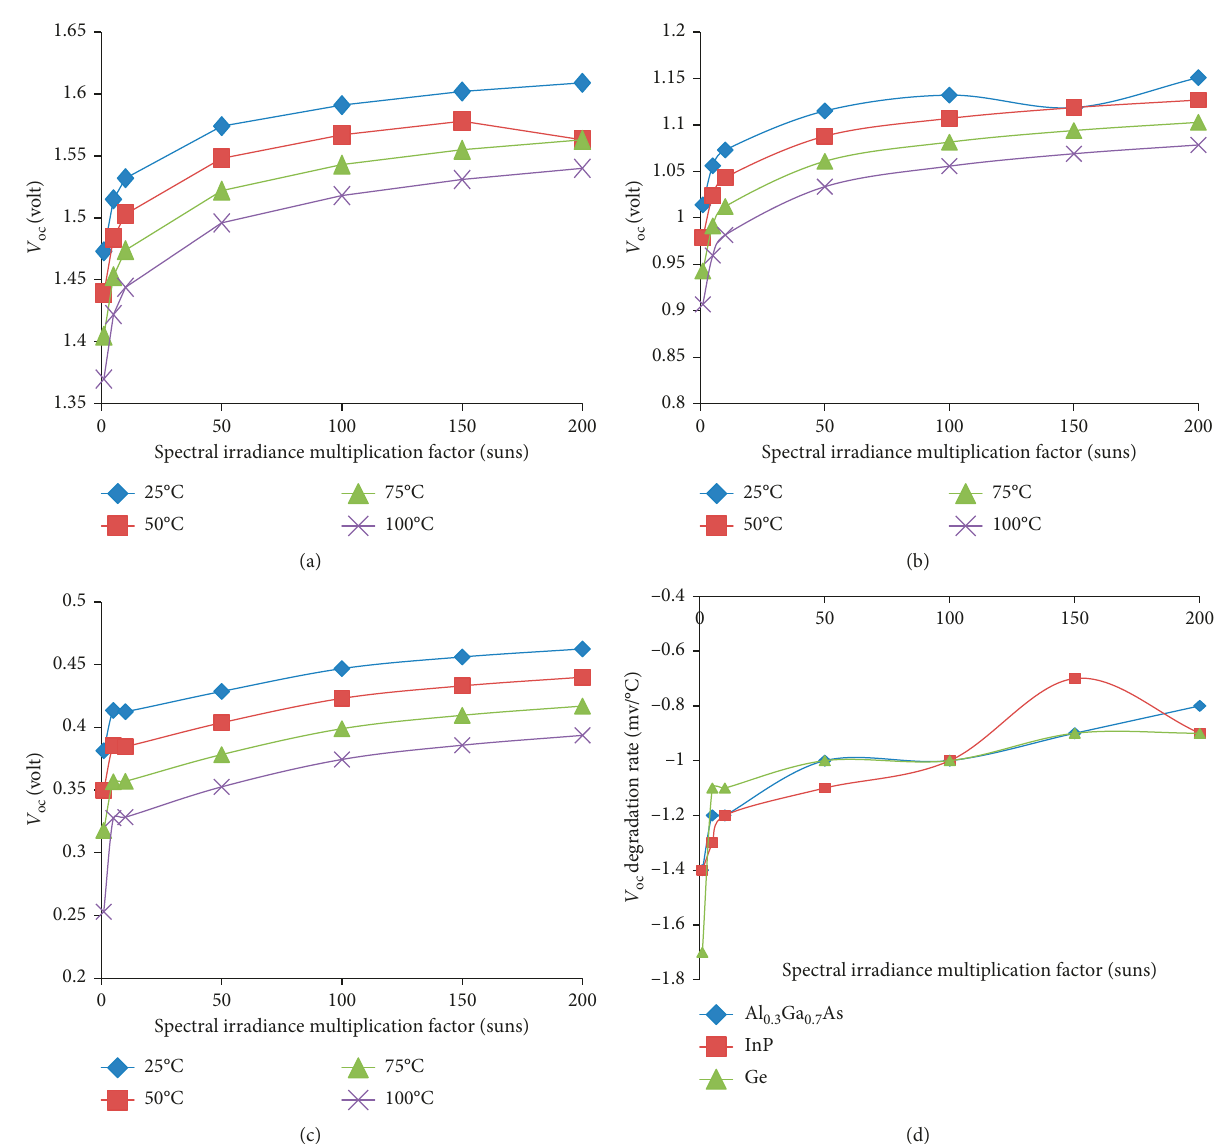
Figure 4: The effect of spectral irradiance multiplication to the open-circuit voltage ( V subcell InP, and (c) the third subcell Ge. The degradation rate of V oc for each subcell is shown in